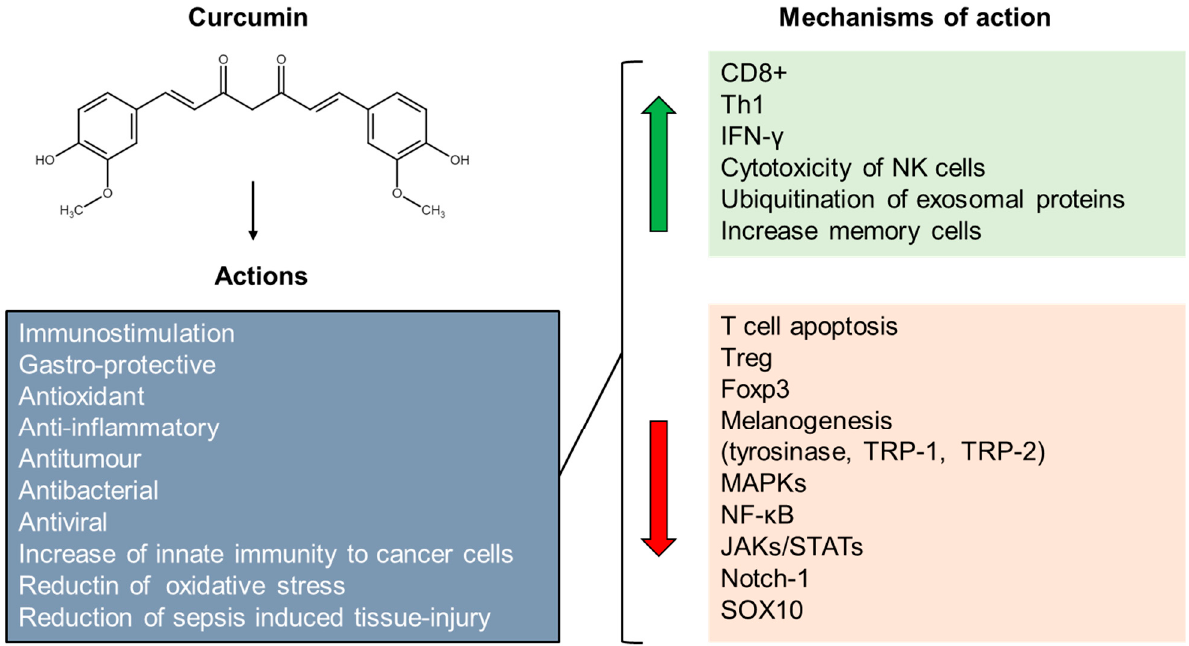
Figure 8. Mechanisms of action of curcumin.